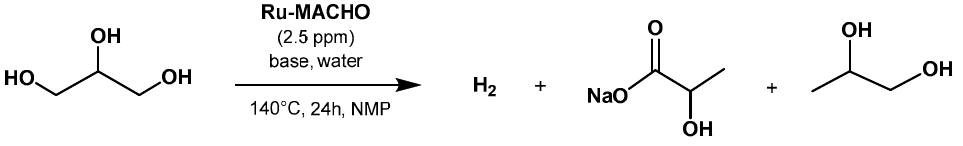
work. Using only 2.5 ppm of Ru-MACHO and 1.08 eq. of KOH (7.3 M), it was possible to obtain full conversion and 67% yield of sodium lactate. conversion and 67% yield of sodium